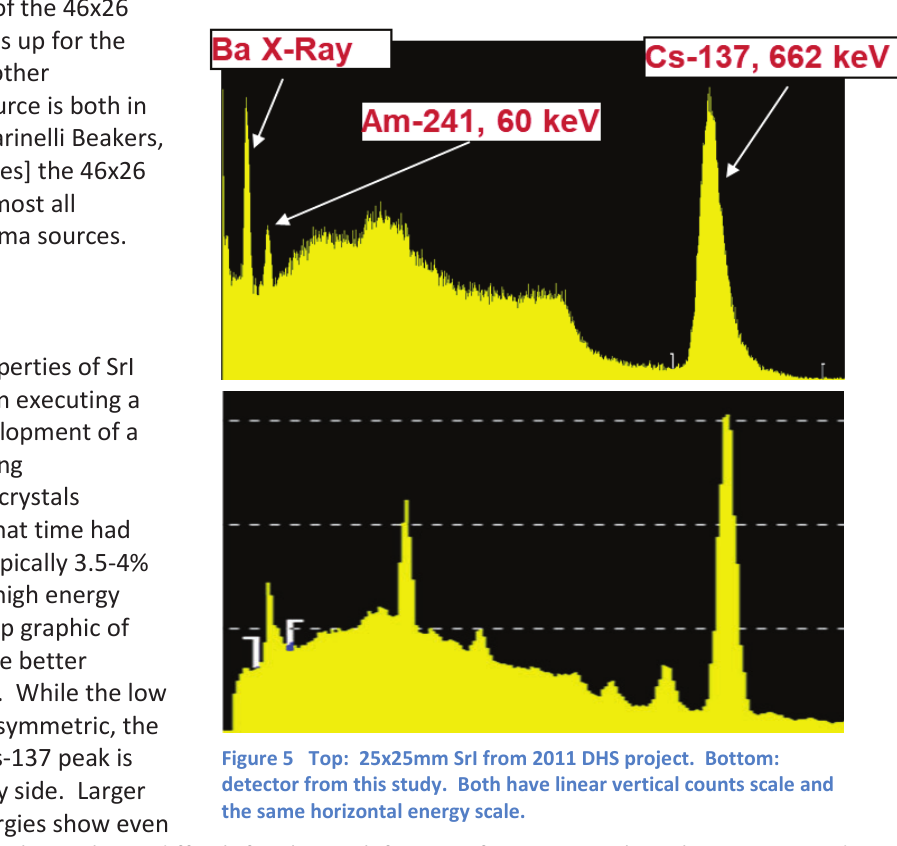
Figure 5 Top: 25x25mm SrI from 2011 DHS project. Bottom: detector from this study. Both have linear vertical counts scale and the same horizontal energy scale.